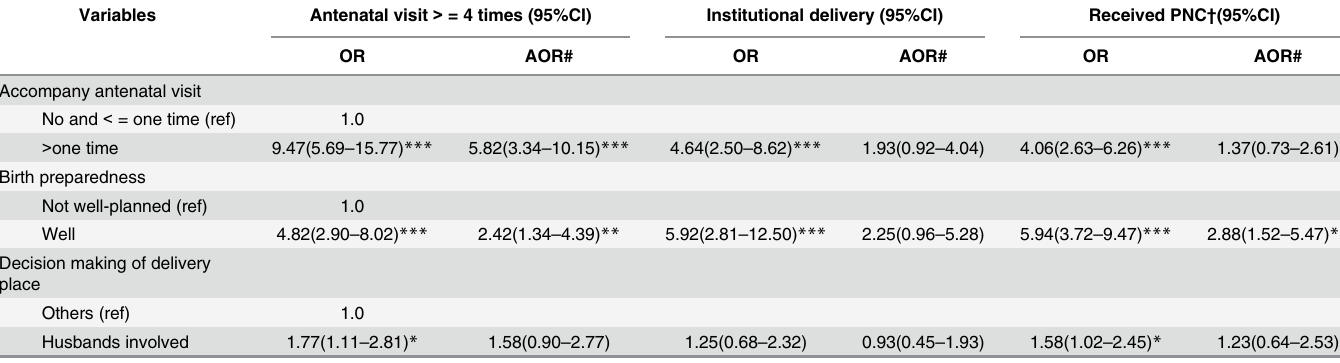
Table 4. Multivariable Analysis for the Associations between Husband ’ s Involvement and Utilization of Maternal Care Services (n = 426). Variables Antenatal visit > = 4 times